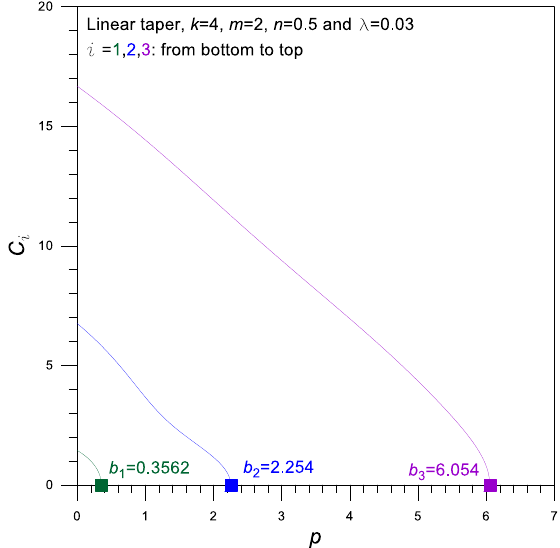
Figure 7. Frequency parameter 𝐶 𝑖 versus load parameter 𝑝 curves.